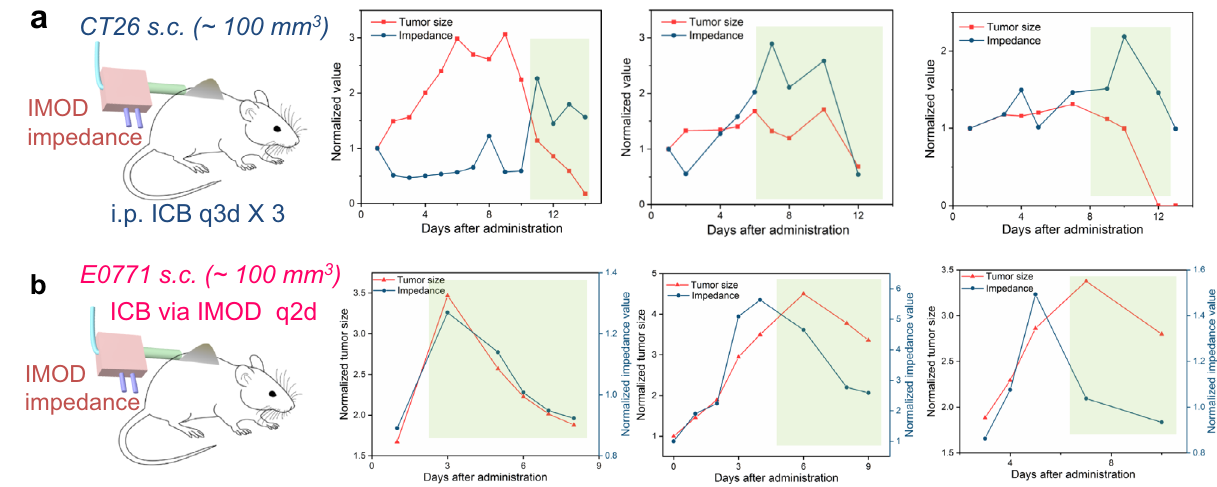
Fig. 5 Correlation between tumor shrinkage and decreased impedance value (highlighted in light green). a Representative results for treatment of s.c. CT26 tumor by intraperitoneally (i.p.) injections of ICB antibodies, with tumor impedance measured by an implanted IMOD. b Representative results for treatment of s.c. E0771 tumor by injection of ICB antibodies every 2 days via an implanted IMOD. Tumor impedance values were measured via IMOD before administration of treatment. Detailed results for both experiments are provided in Supplementary Fig.